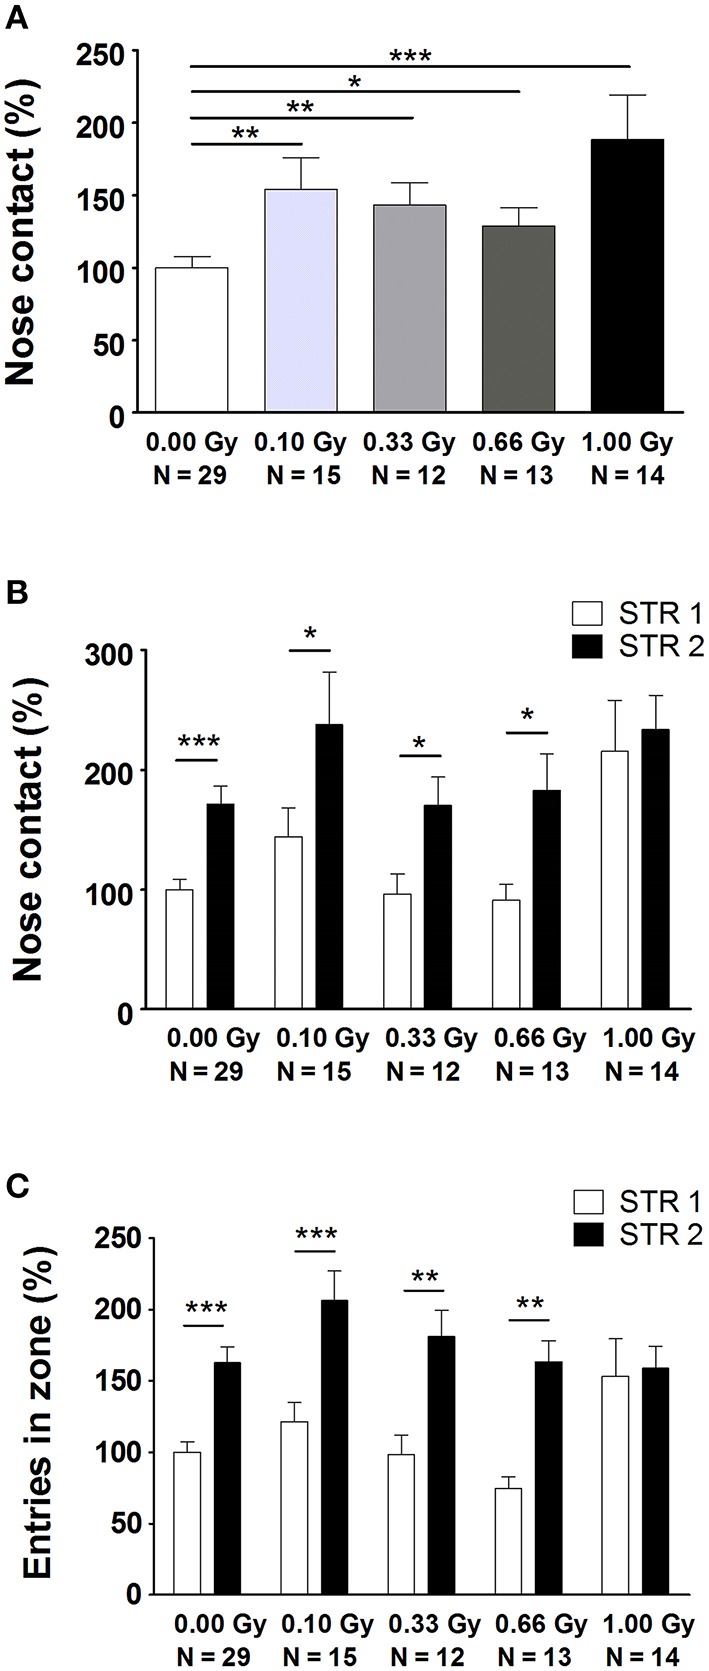
Prenatally irradiated animals show an increased social behavior, as evidenced by the amount of nose contact in the SPSN task. (A) During the second trial of the SPSN test, all animals exposed to radiation at E11 engaged more time in nose contact with the STR in the wire cage as compared to sham-irradiated animals. (B,C) In the following trial, a second STR, STR2, was placed in the other wire cage and time spent in contact (B), as well as entries in the nose contact zone (C), between STR1 and STR2 were compared. Here, all animals, except for those exposed to 1.00 Gy, showed a significantly increased interest in STR2, indicative for social memory. Data are presented as mean ± SEM. Horizontal lines with an asterisks indicate significant differences between means of two groups. *P < 0.05, **P < 0.01, ***P < 0.001. The number of animals used is indicated in the graphs (N). E, embryonic day; Gy, Gray; SPSN, sociability and preference for social novelty; STR, stranger mouse.